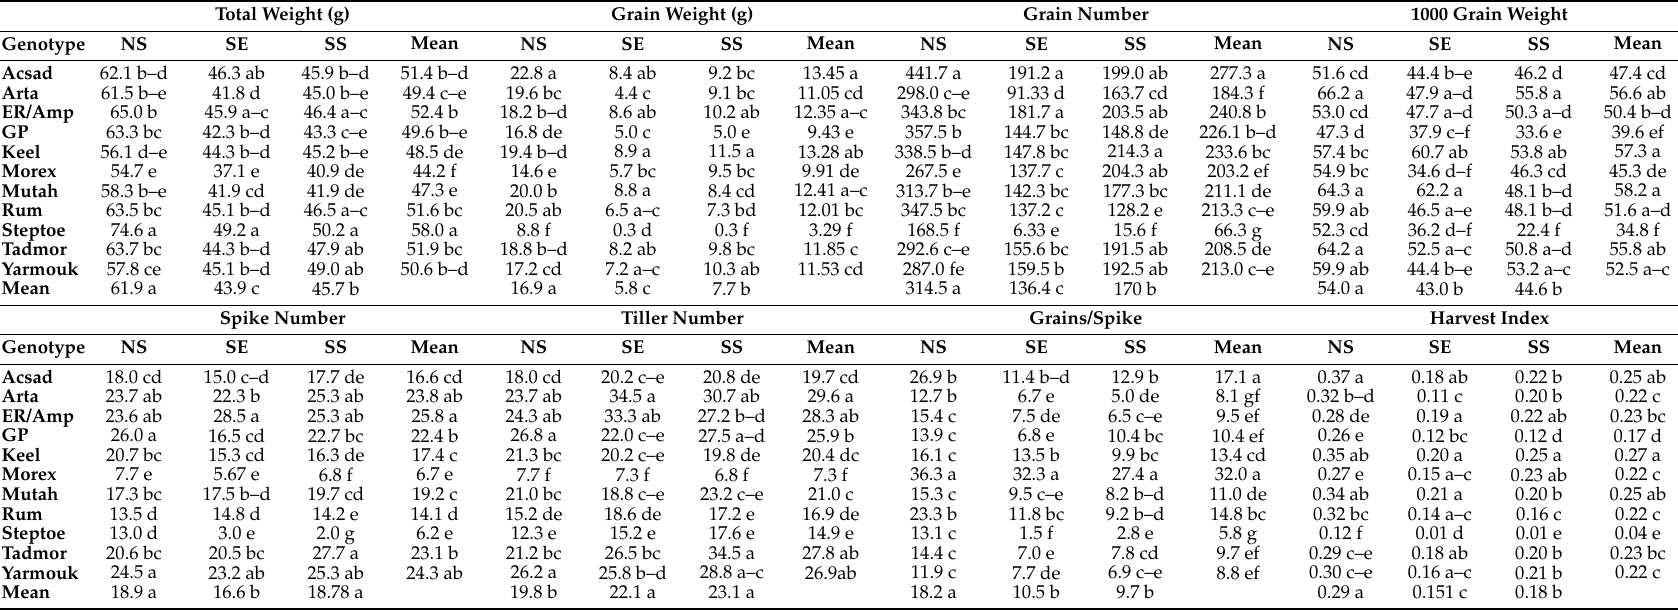
Table 4. Total weight, Grain yield, grains number, and 1000 grain weight of 11 barely genotypes grown under well-watered conditions (NS) and subjected to drought stress conditions at different stages (stem elongation (SE) and seedling